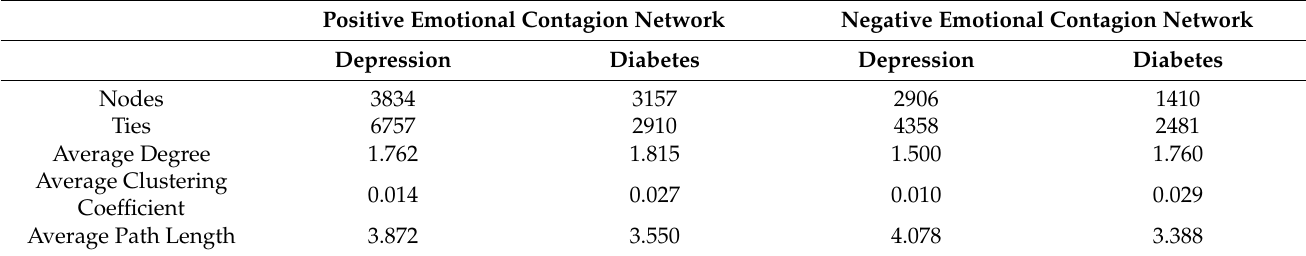
Table 4. Descriptive statistics for the positive and negative emotional contagion